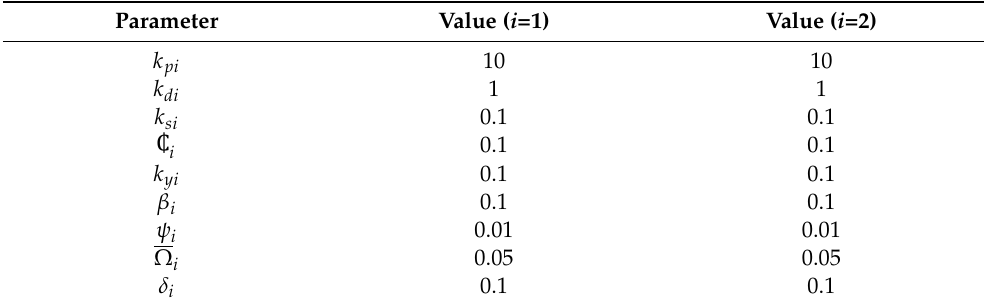
Figure 2. Membership function of fuzzy input of the 𝑖 (cid:3047)(cid:3035) subsystem.